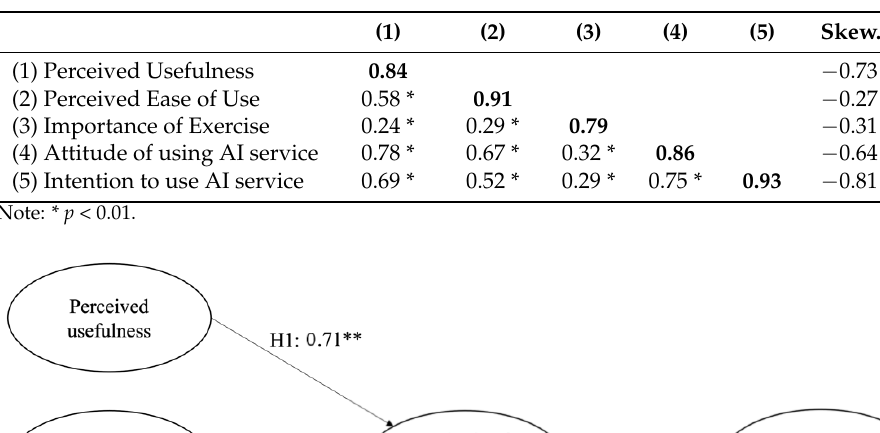
Table 2. Constructs, correlations, skewness (Skew), and kurtosis (Kurt).